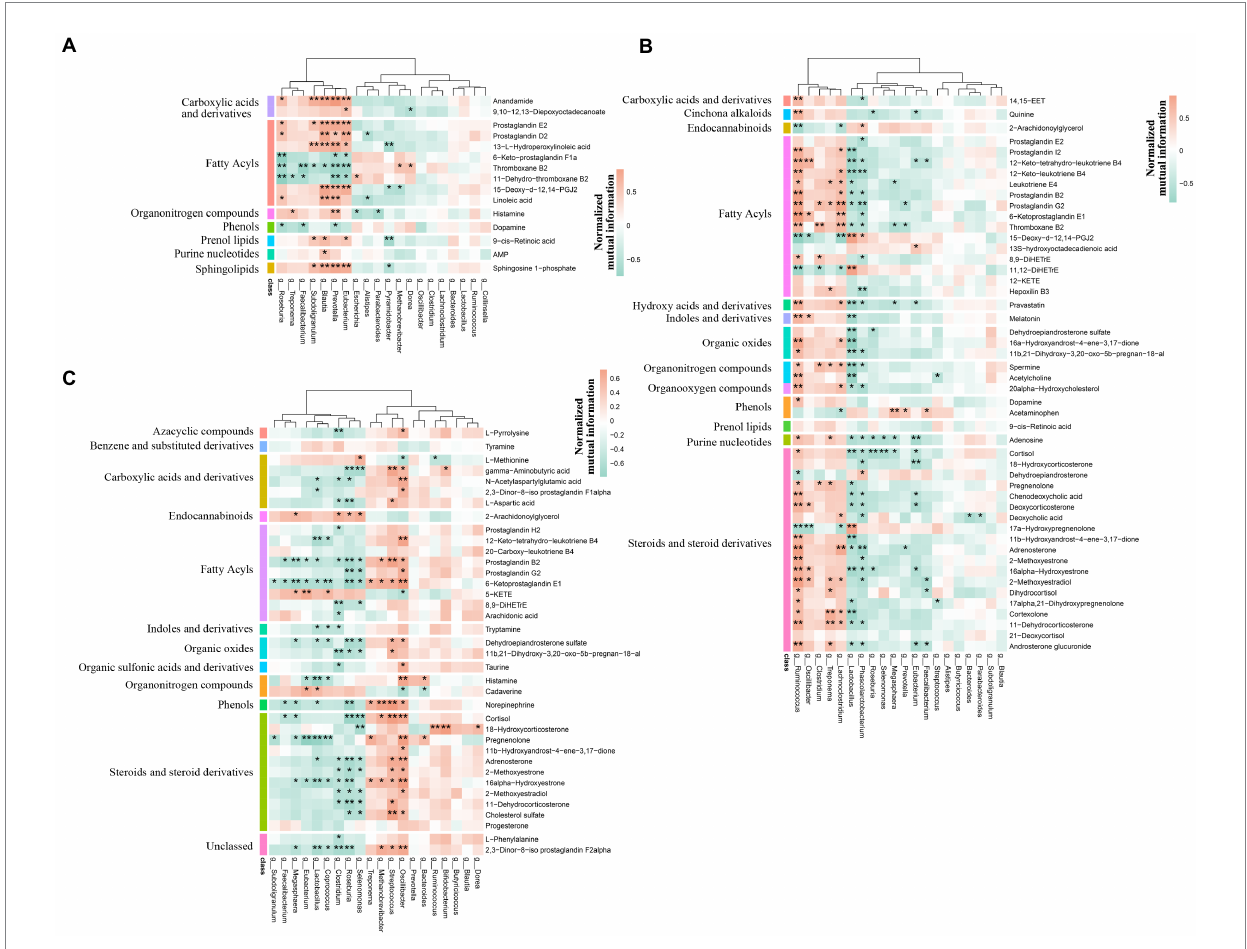
FIGURE 12 Spearman’s correlation analysis of microbiome and metabolism. The correlation analysis was performed by stages, including (A) the pre-weaning stage, (B) the weaned stage, and (C) the growth stage. Bacteria were deduced from the top 20 genera which accounted for more than 80% of the microbial sequence reads, and metabolites were deduced from the different metabolic pathways by stages. The color represents the correlation coefficient. Only correlation coefficient beyond 0.6 and p- value below 0.05 were considered significant and displayed in bold in Supplementary Tables; in figures, ** and * denote, respectively, p- values below 0.01 and